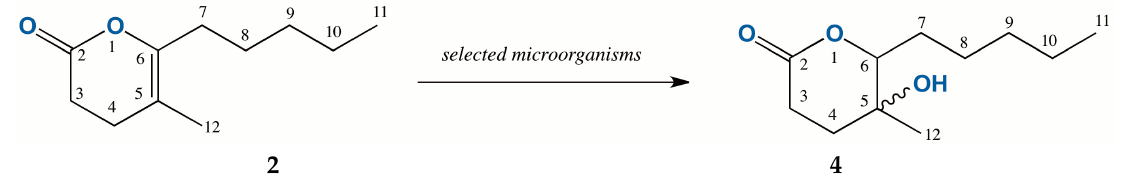
Figure 2. Biotransformation of ( 2 ) with F. culmorum AM10, F. equiseti AM15 and B. bassiana AM278.